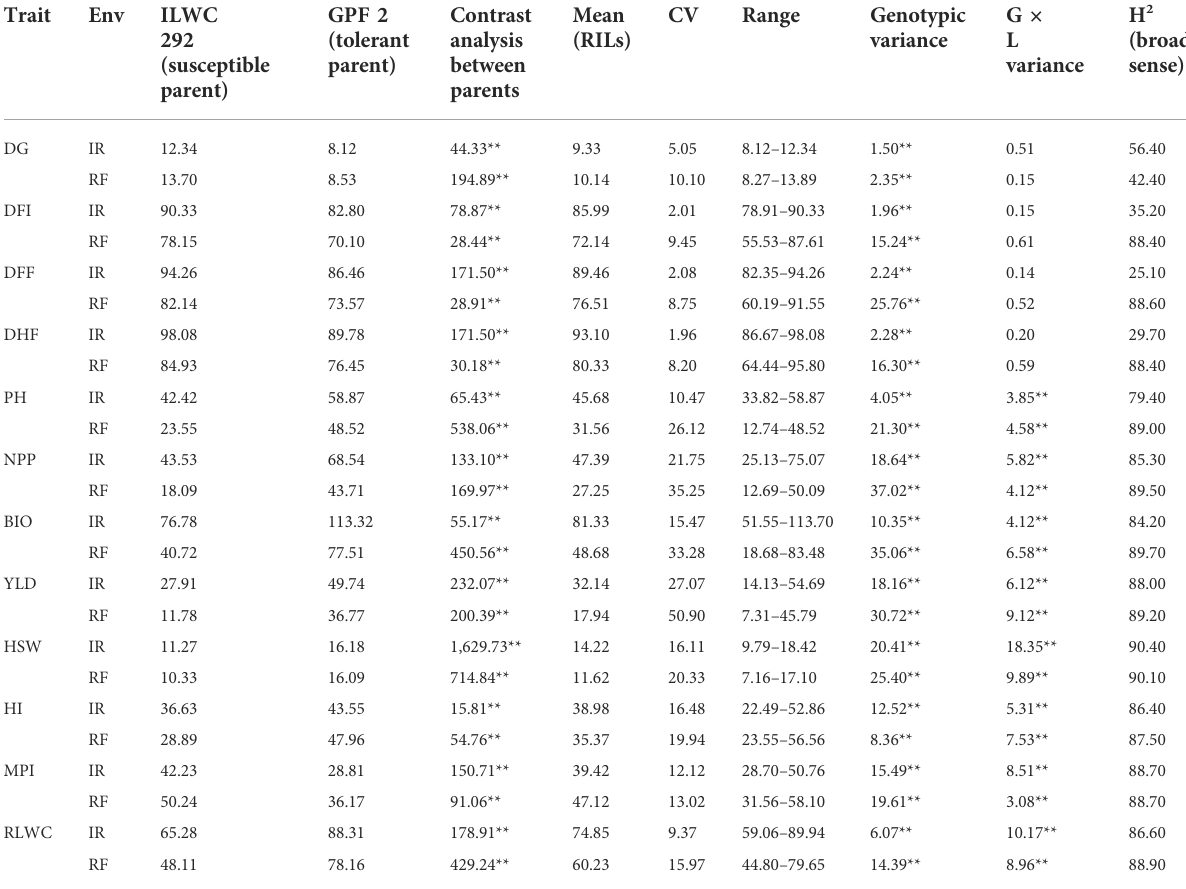
TABLE 1 Mean performance of chickpea RIL population for various morphological and physiological traits under irrigated (IR) and rainfed (RF) conditions (Ludhiana and Faridkot pooled). GPF 2 Contrast Trait Env ILWC (tolerant analysis 292 parent) between (susceptible parent)